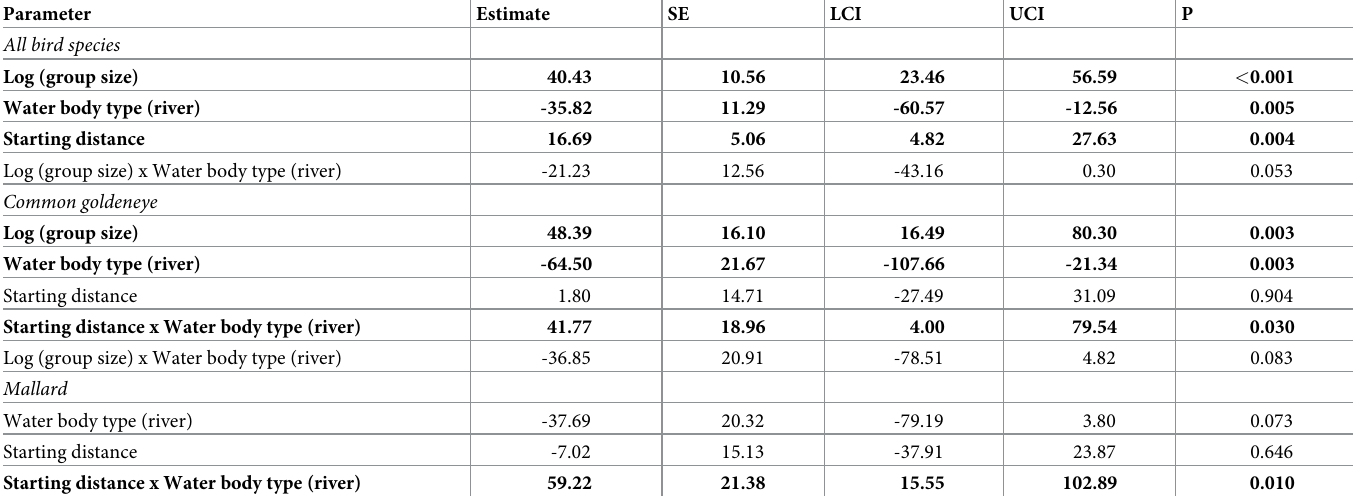
Table 2. The best model explaining the flight initiation distance in European waterbirds approached from a boat in 2015 and 2016 in southeast Norway, separately for (1) all birds species together, (2) goldeneyes, and (3) mallards. β , estimated coefficient; SE, standard error; LCI, lower limit of the 95% confidence interval; UCI, upper limit of the 95% confidence interval; bold font indicates informative